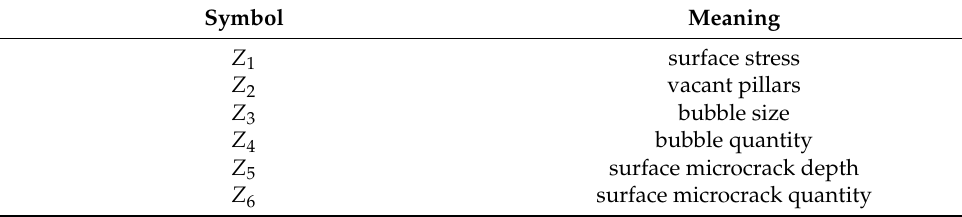
Table 1. Characteristic parameters and symbolic meanings of TVG.